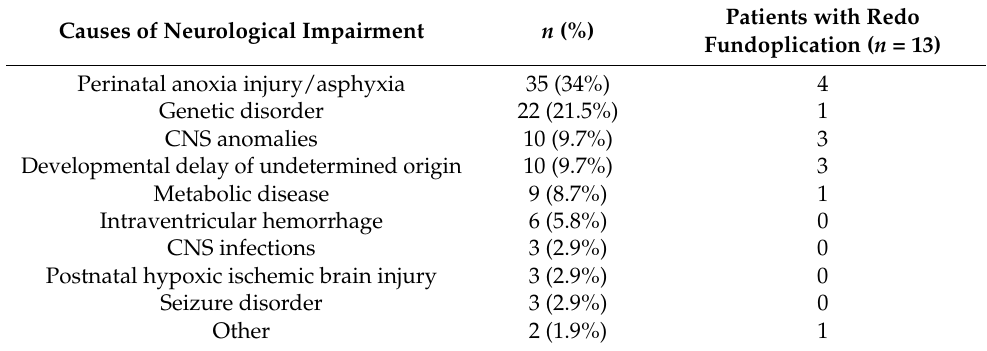
Table 2. Causes of neurological impairment and number of patients with redo